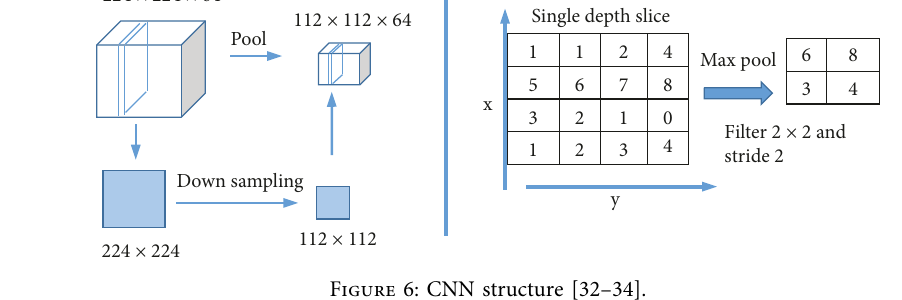
Figure 6: CNN structure